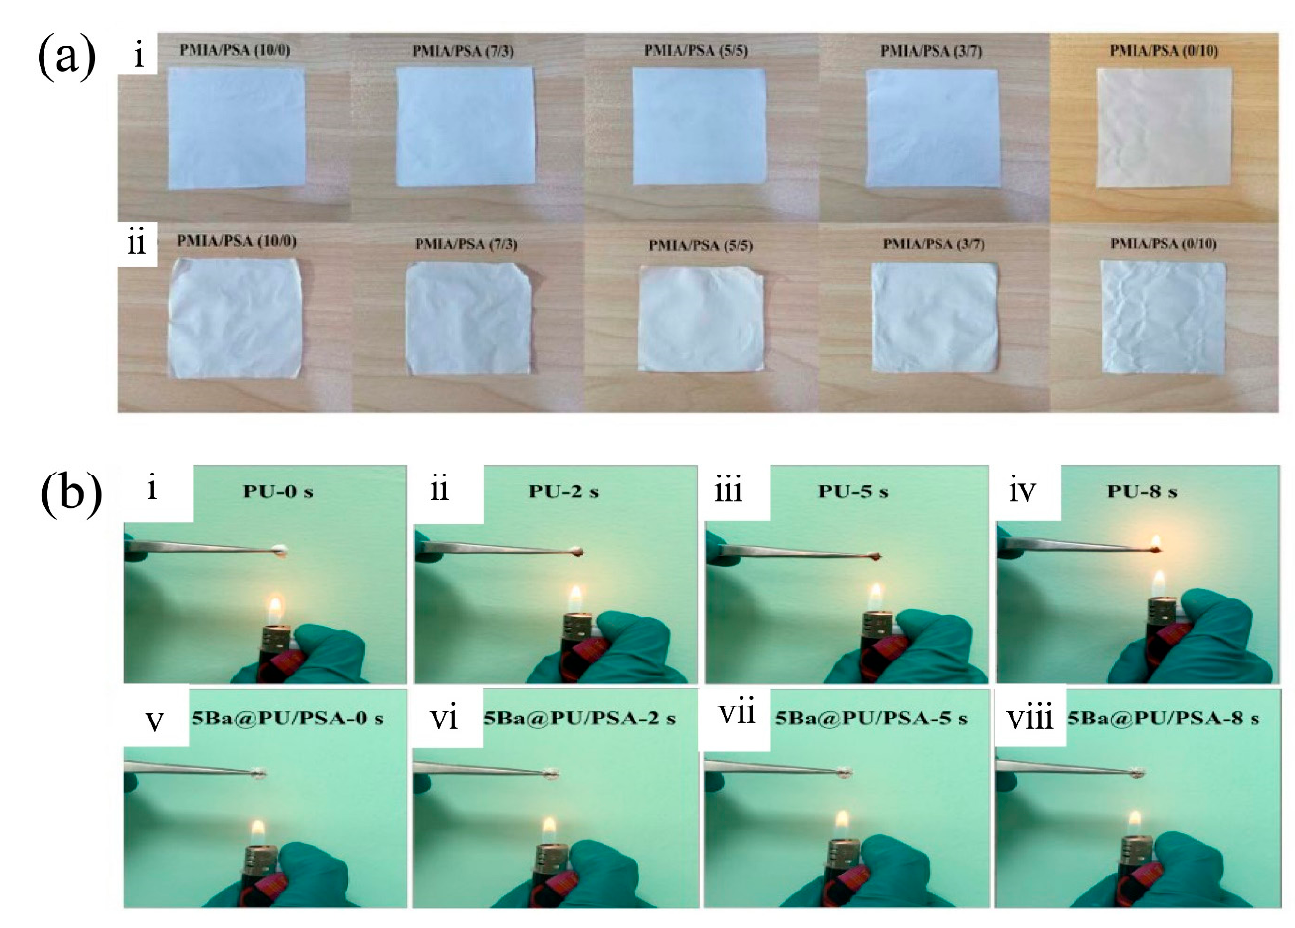
Figure 9. ( a ) Effect of heat treatment on PMIA, PSA and PMIA/PSA composite nanofibrous membranes, ( i ) before and ( ii ) after thermal exposure at 250 °C for 200 h. PMIA/PSA. Reprinted with permission from ref. [69]. Copyright 2019 IOP Publishing Ltd. ( b ) Combustion test of PU ( i – iv ) and Ba@PU/PSA ( v – viii ) membrane. Reprinted with permission from ref. [70]. Copyright 2020 Elsevier B.V.